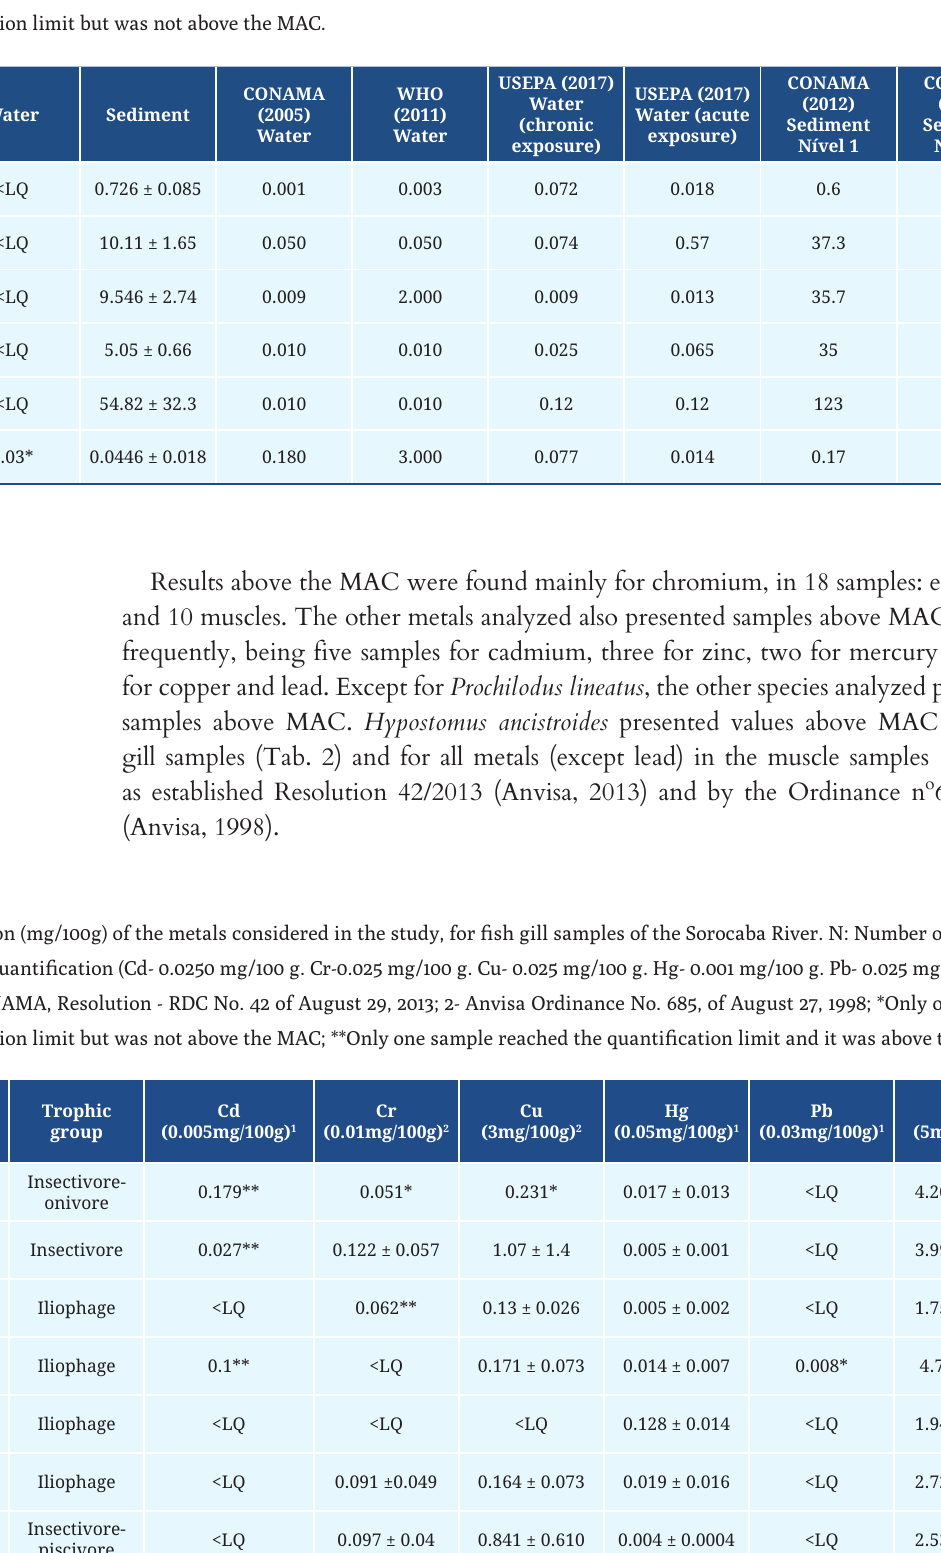
TABLE 1 | Average concentration of metals in water (mg/L −1 ) and sediment (mg/Kg −1 ) (mean±SD) of the Sorocaba River. *Only one sample reached the quantification limit but was not above the MAC.